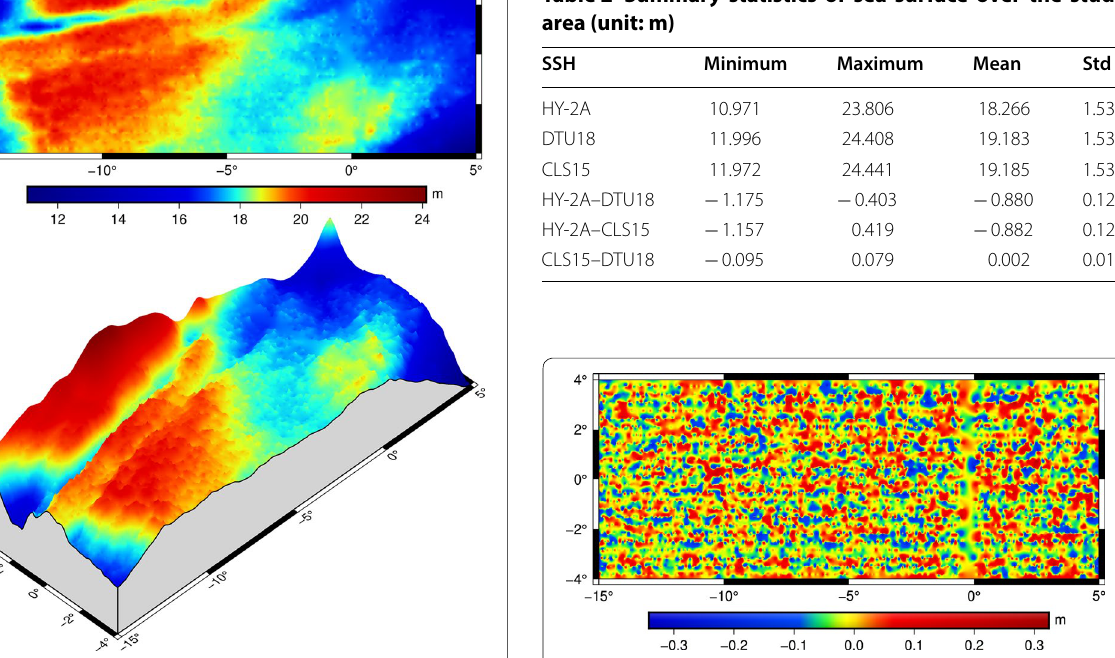
Table 2 Summary statistics of sea surface over the study